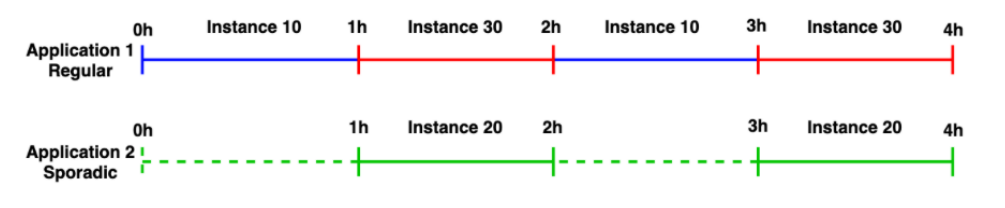
Figure 4. Example of four hours of operation of three schedules with two instances associated with the regular application and one critical application with one